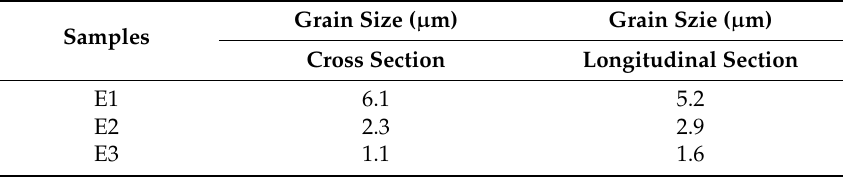
Table 3. Grain size of the molten pool of the LAMed Mg-Zn-Zr